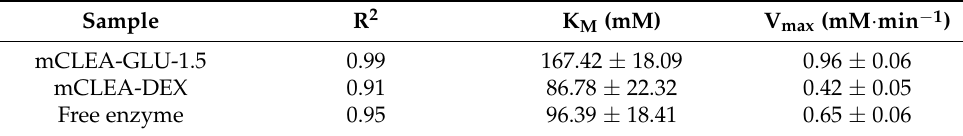
Figure 2. Influence of Lactose concentration in the initial rate of hydrolysis catalysed by free and immobilised β -galactosidase from Aspergillus oryzae . Reactions were carried out in potassium phosphate buffer (pH 6.6), with 0.1 mM MnCl 2 as a cofactor, at 37 °C. The lines represent the non-linear fit of the Michaelis–Menten model using Origin 8.5. Table 8. Kinetic parameters for mCLEAs and free enzyme.